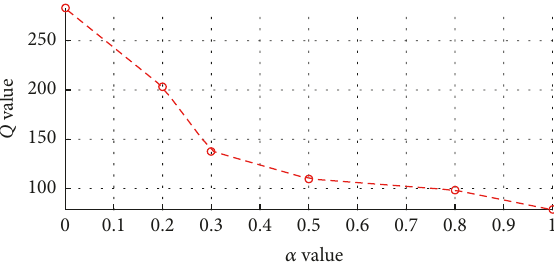
Figure 5: Node topology of wireless sensor network for coal mine robot.